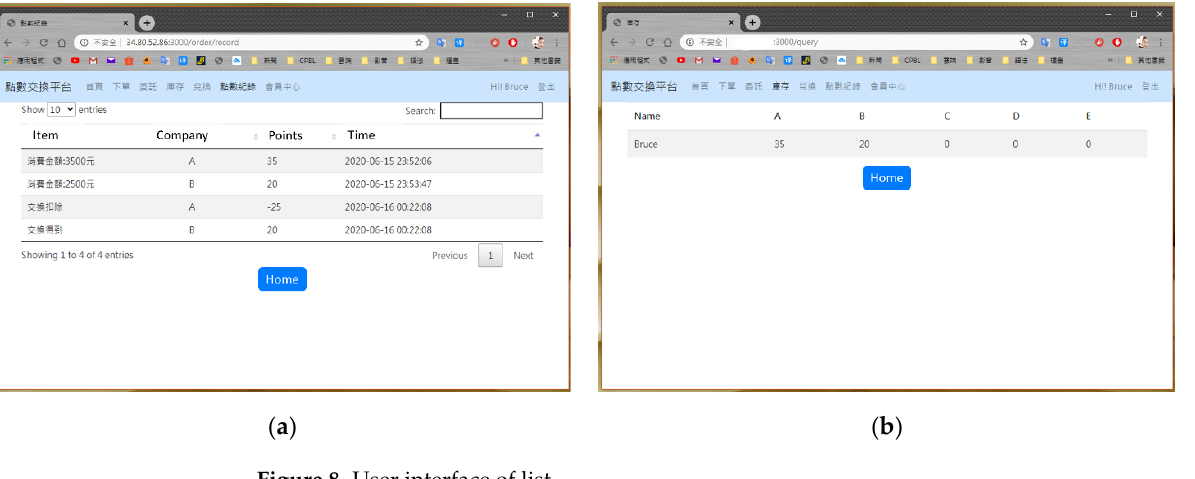
Figure 8. User interface of